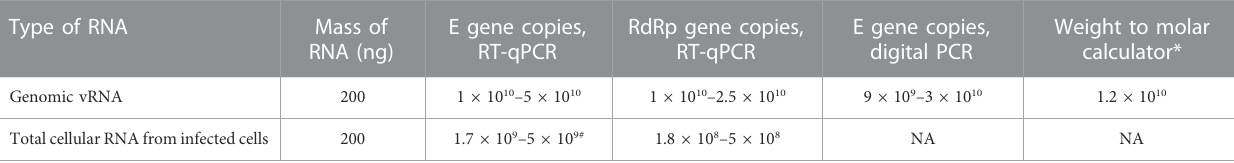
TABLE 1 RNA mass vs. virus copies analyzed with different methods from different RNA samples. The variations are due to differences between RNA batches. Type of